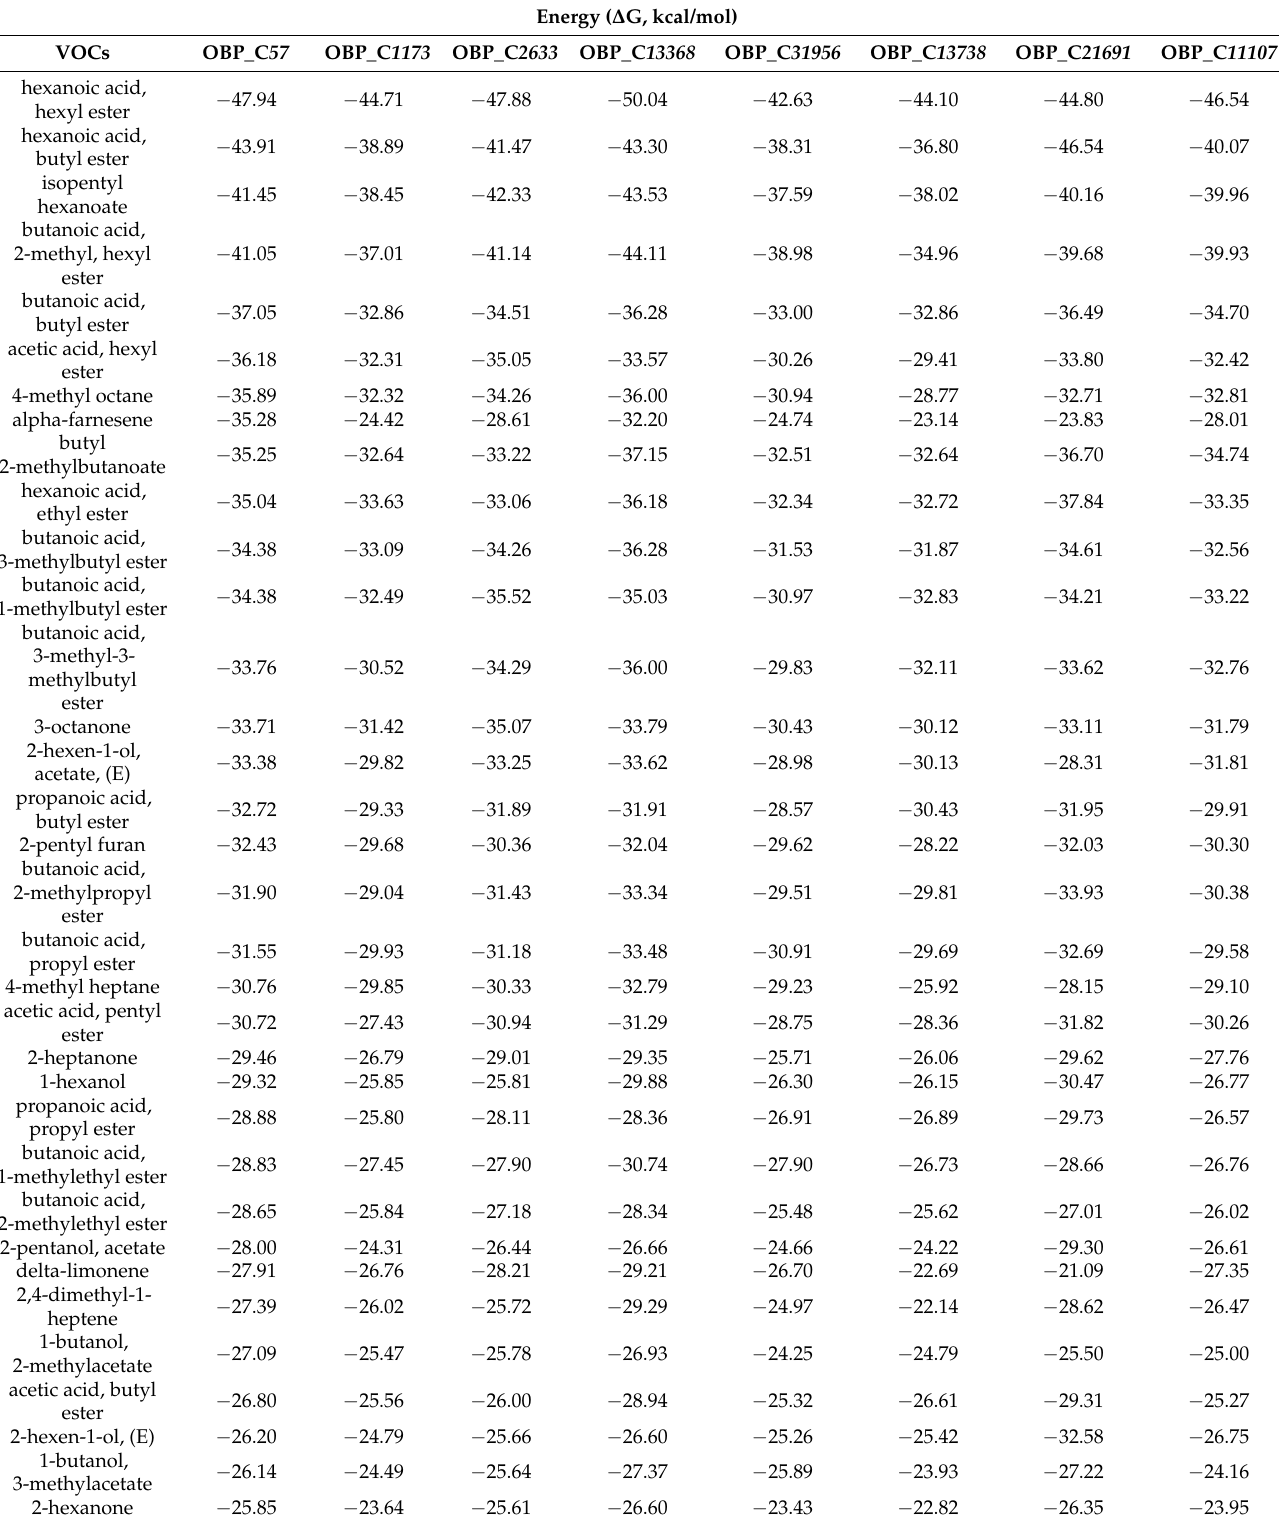
Table 6. Virtual screening based on molecular docking. SwissDock server (https://www.swissdock.ch/docking/ accessed in June 2021) was used to simulate all the possible interactions between 57 selected VOCs indicative of organic decomposition and 8 putative OBPs during the computational analysis. Free binding energy values ( ∆ G, kcal/mol) are listed, showing the best cluster of each specific interaction. All the identified OBPs, in common between H. illucens larvae and adults, seem to interact almost in the same way in presence of a specific